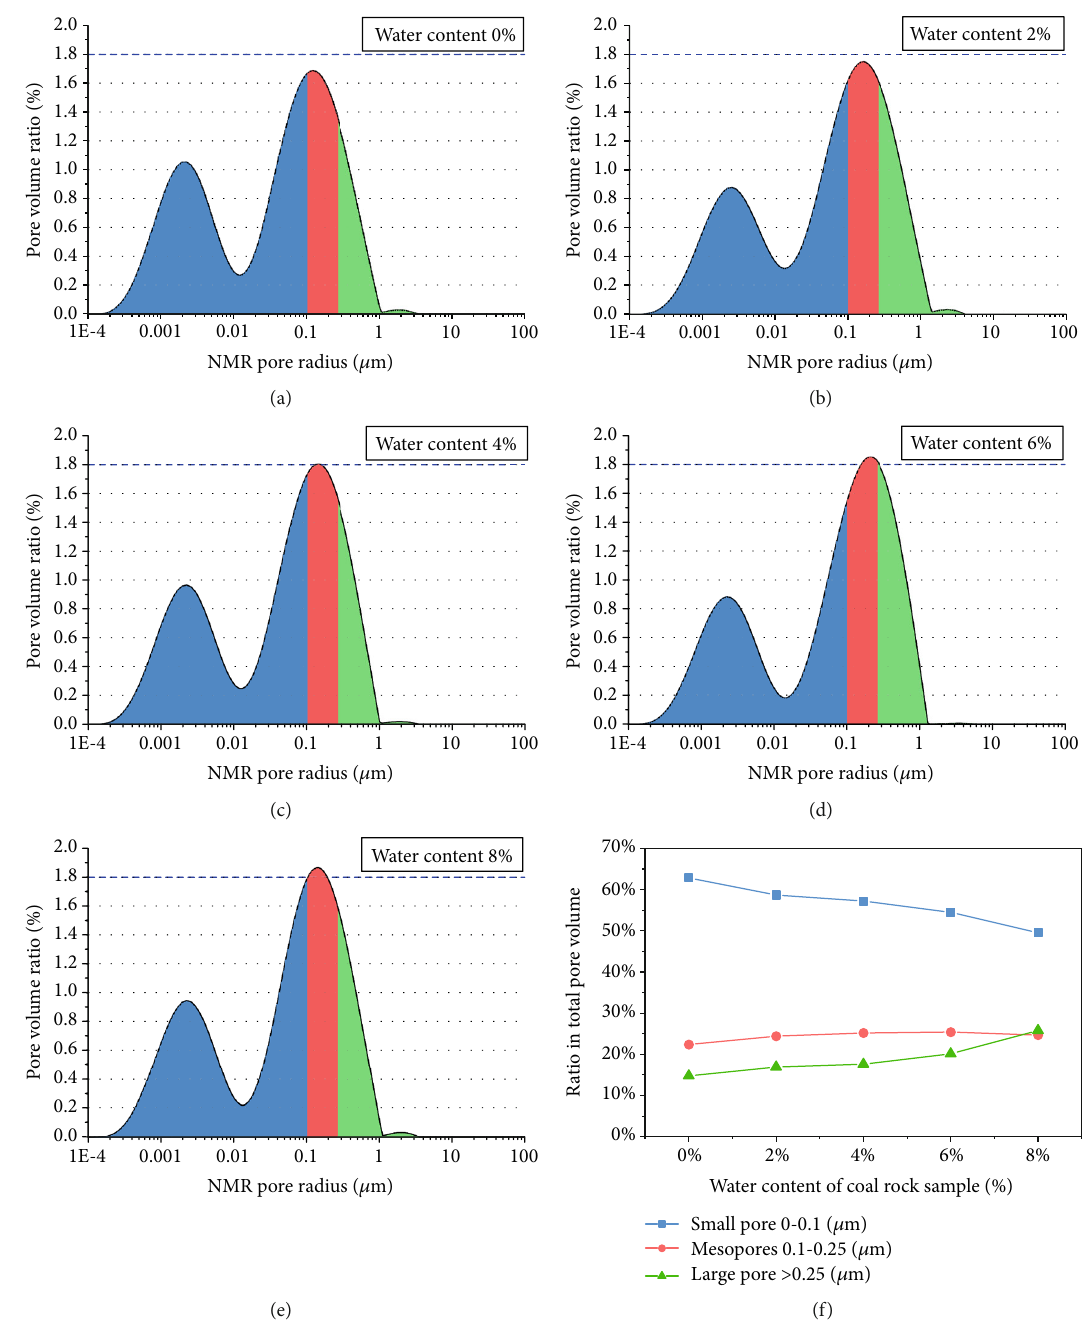
Figure 2: Pore radius distribution of coal rock samples with di ff erent water contents: (a) 0%, (b) 2%, (c) 4%, (d) 6%, and (e) 8%. (f) Variations in the proportion of large, medium, and small pore volumes with water